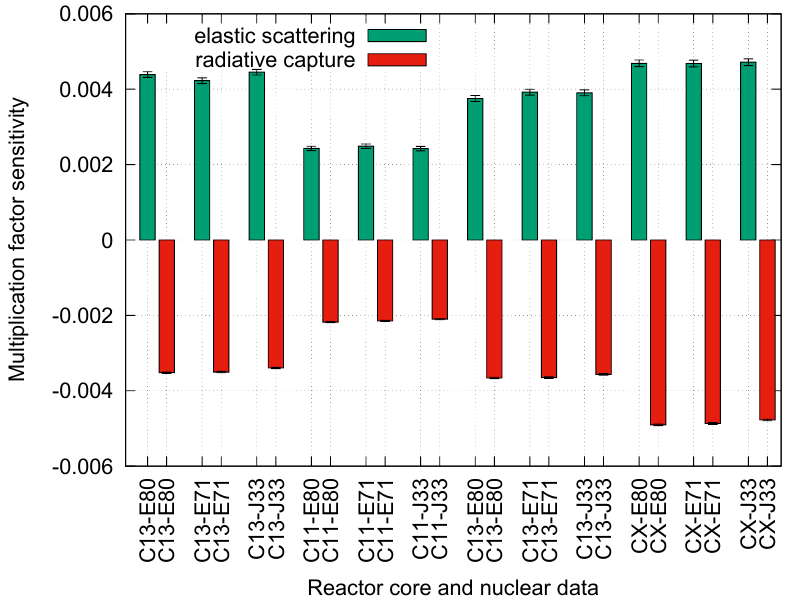
Figure 6: Energy integrated multiplication factor sensitivity in analyzed reactor cores to stainless steel in the reflector